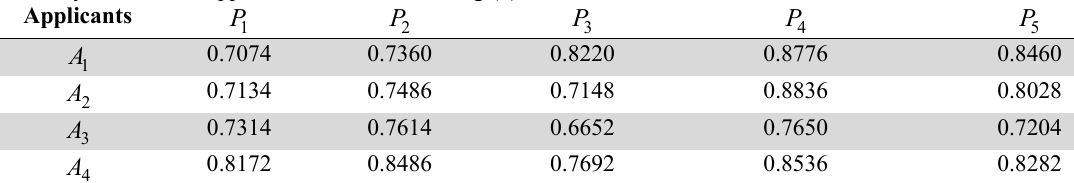
Similarity measure of Applicants vs. Positions using (3)